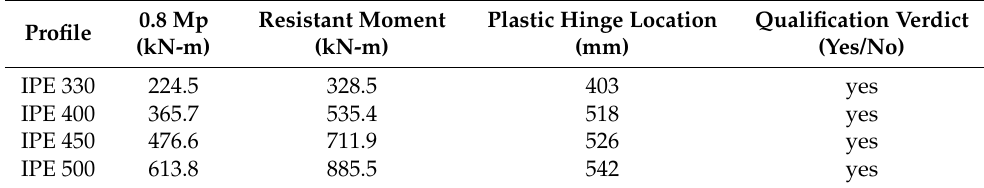
Figure 18. Moment–angle curve for each analyzed configuration. Table 2. Results of the parametric Table 2. Results of the parametric study.